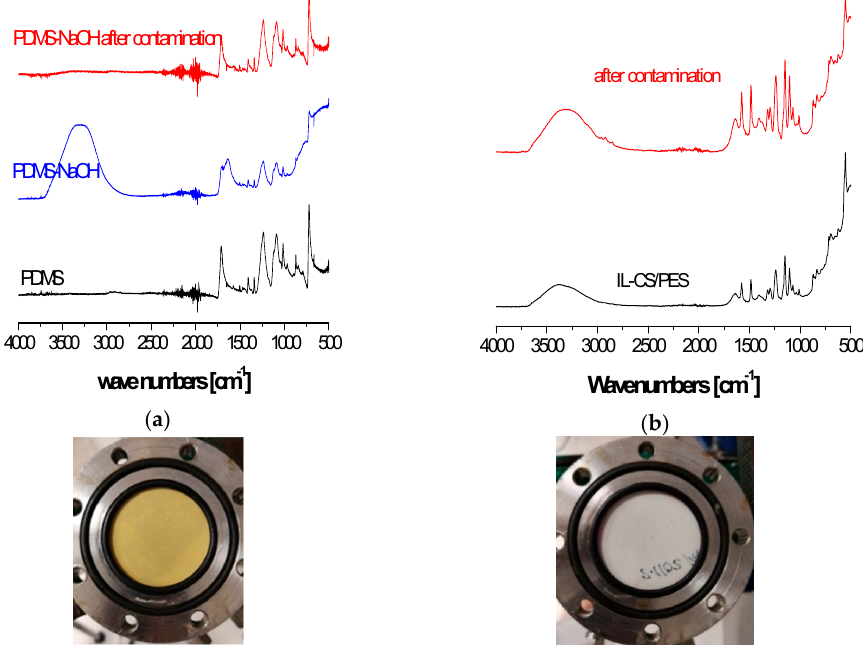
Figure 5. ATR–FTIR spectra of the PDMS ( a ) and IL–CS/PES ( b ) membranes. Pictures of the top surface of the composite membranes after 10 h experimental runs are presented below.